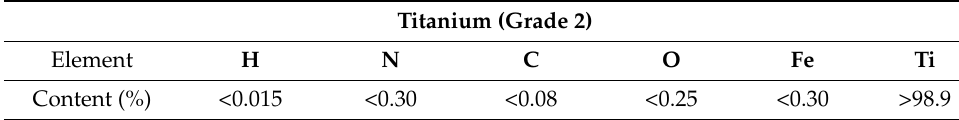
Table 2. Chemical composition of titanium (Grade 2).